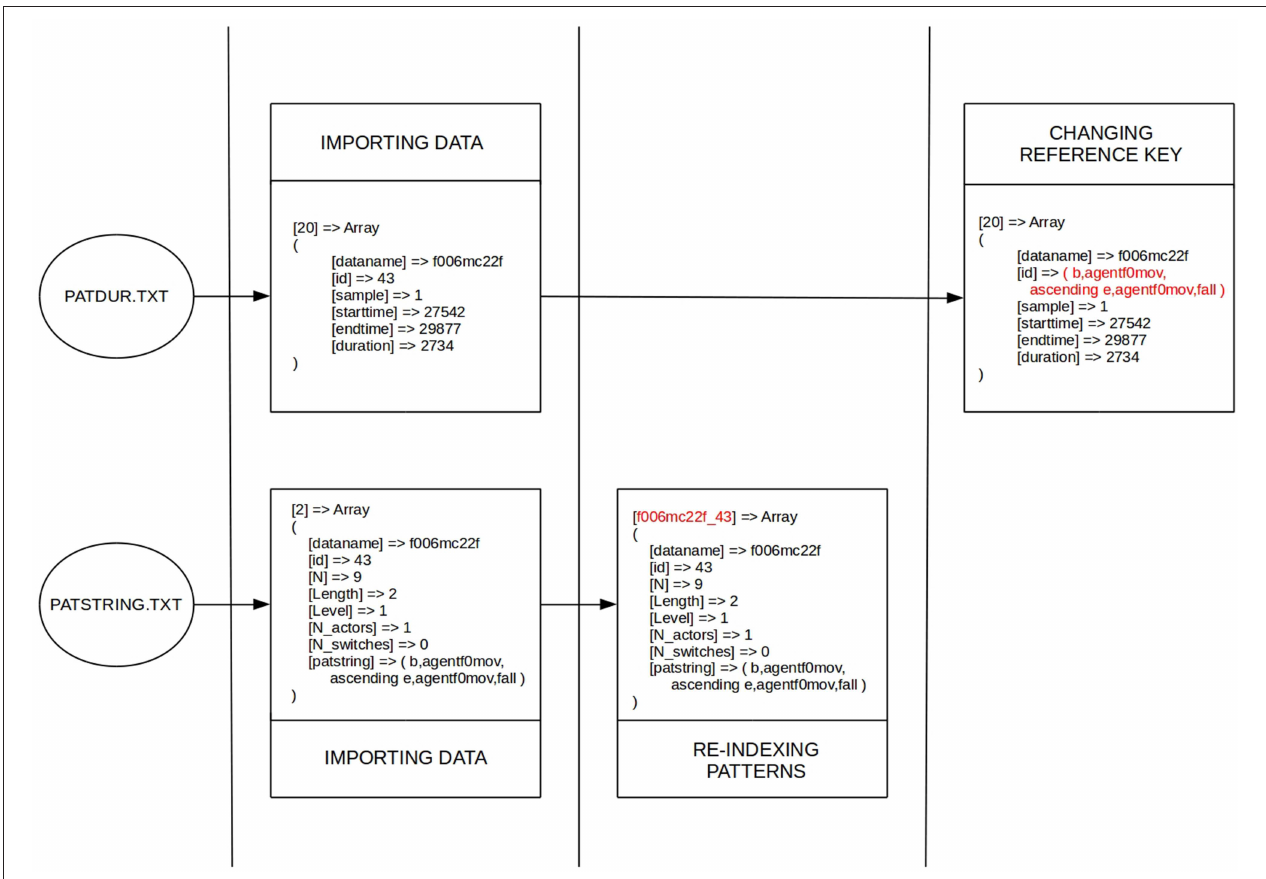
FIGURE 3 | First steps of data processing: working with multidimensional arrays.